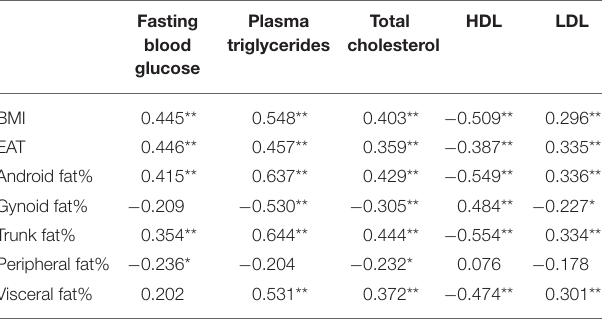
TABLE 4 | Association between regional fat distributions and cardiovascular risk factors in whole